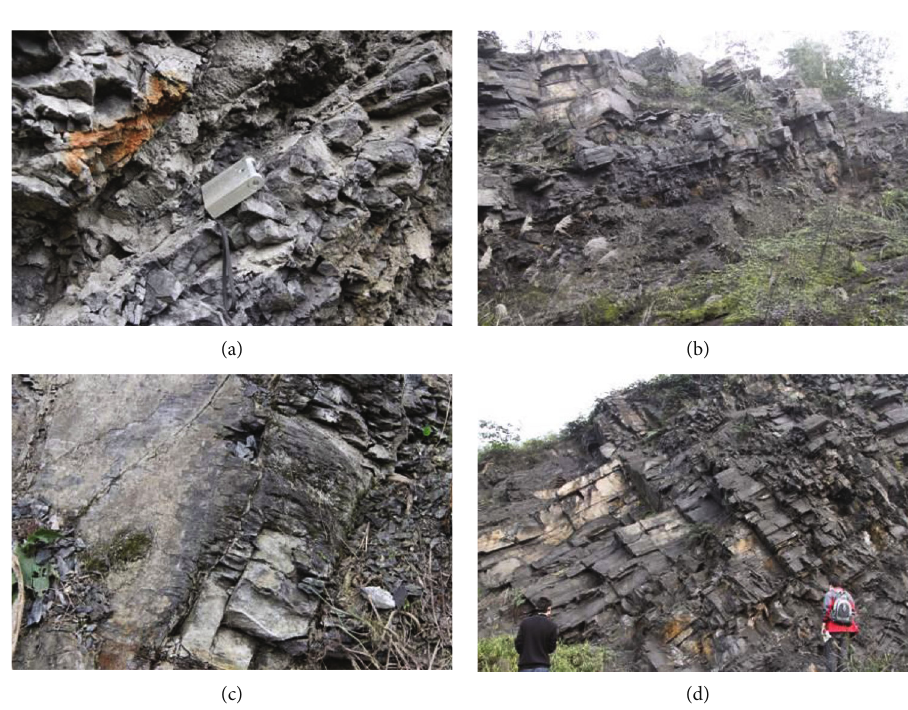
Figure 7: Fractures from the outcrop